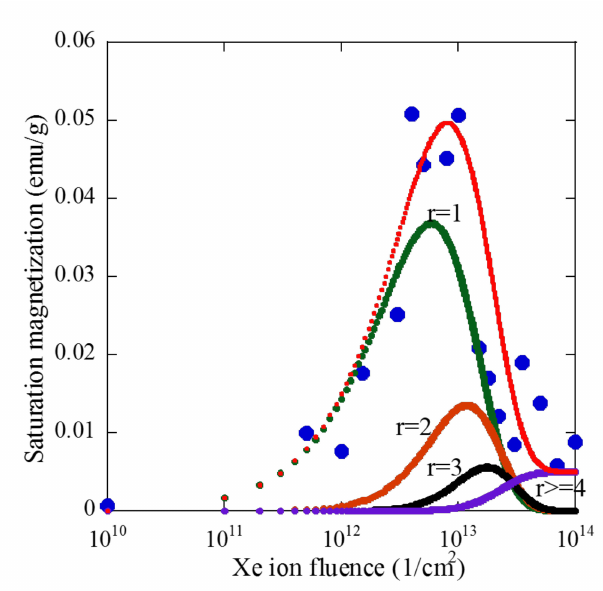
Figure 9. Saturation magnetization of CeO 2 as a function of Xe ion fluence. Solid circles represent the experimental data, and the red curve is the result of calculation using Equation (8). Contribution to the magnetization from each area is also shown.